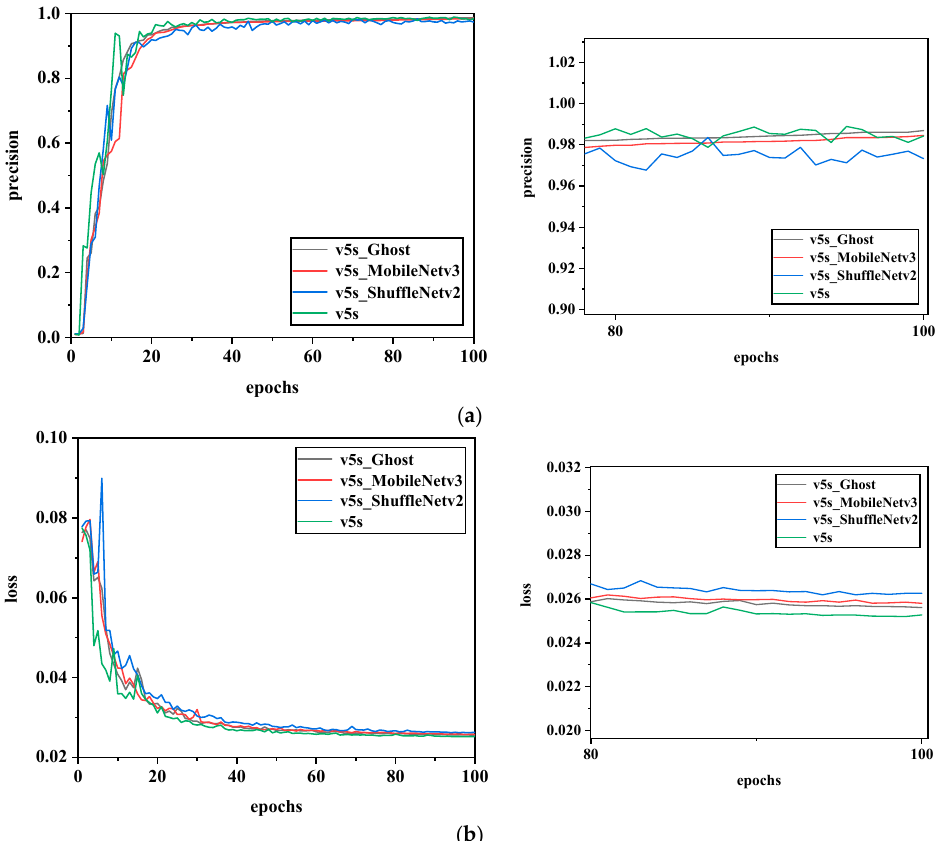
Figure 13. The loss and precision curves of 3D point cloud network training. ( a ) Precision curve of